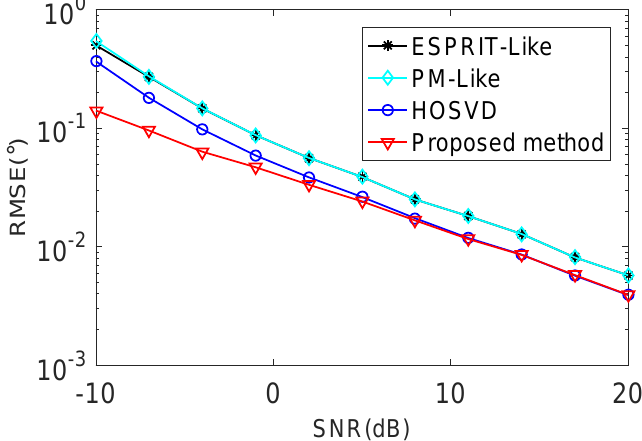
Figure 4. RMSE performance comparison versus SNR in the presence of weak mutual coupling.